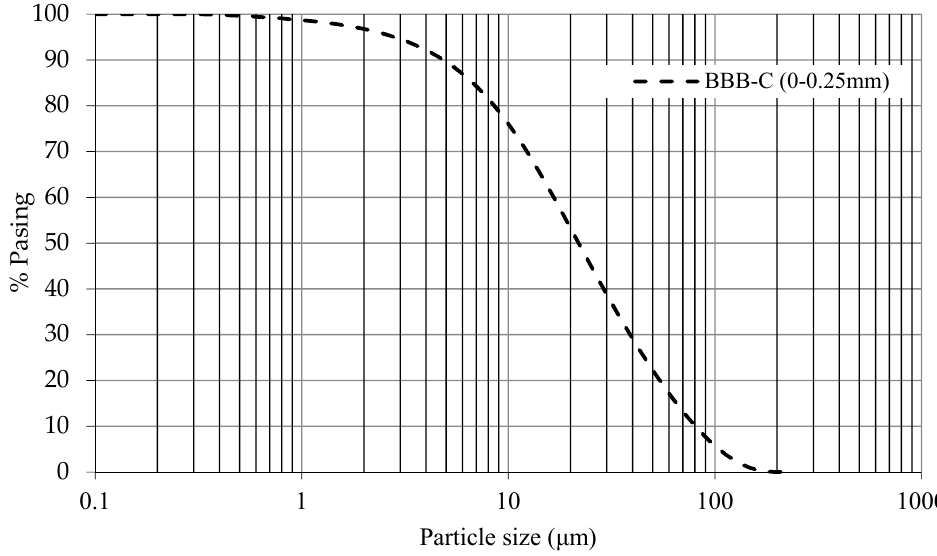
Figure 3. Particle size distribution curve of BBA-Crushed.